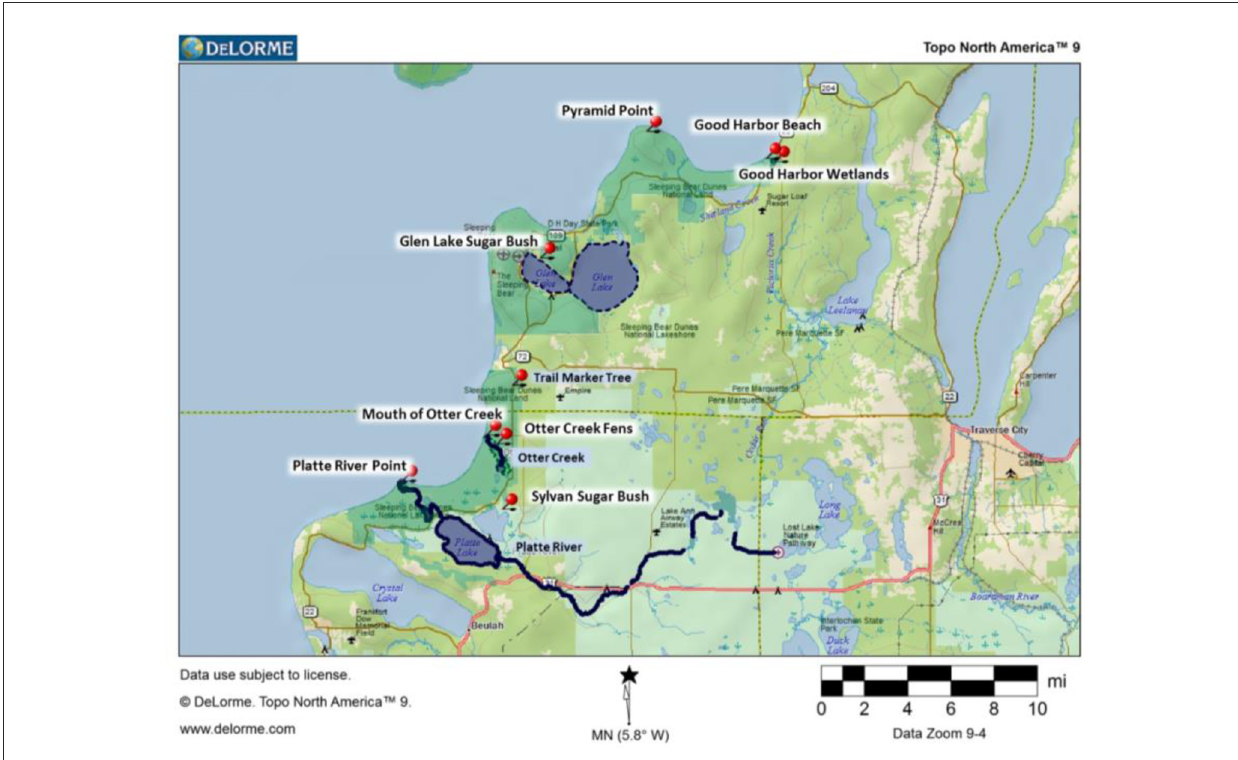
FIGURE1 Study areas in sleeping bear dunes national lakeshore.